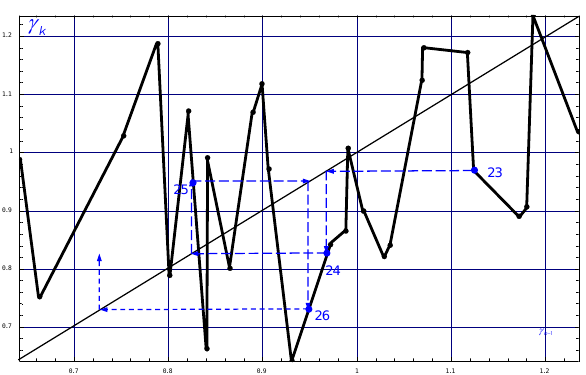
Fig. 13. Lamerey-K¨onigs diagram showing how predictions of the next few solar cycles can be iteratively derived from the mapping of Fig. 11, starting from the last observed cycle